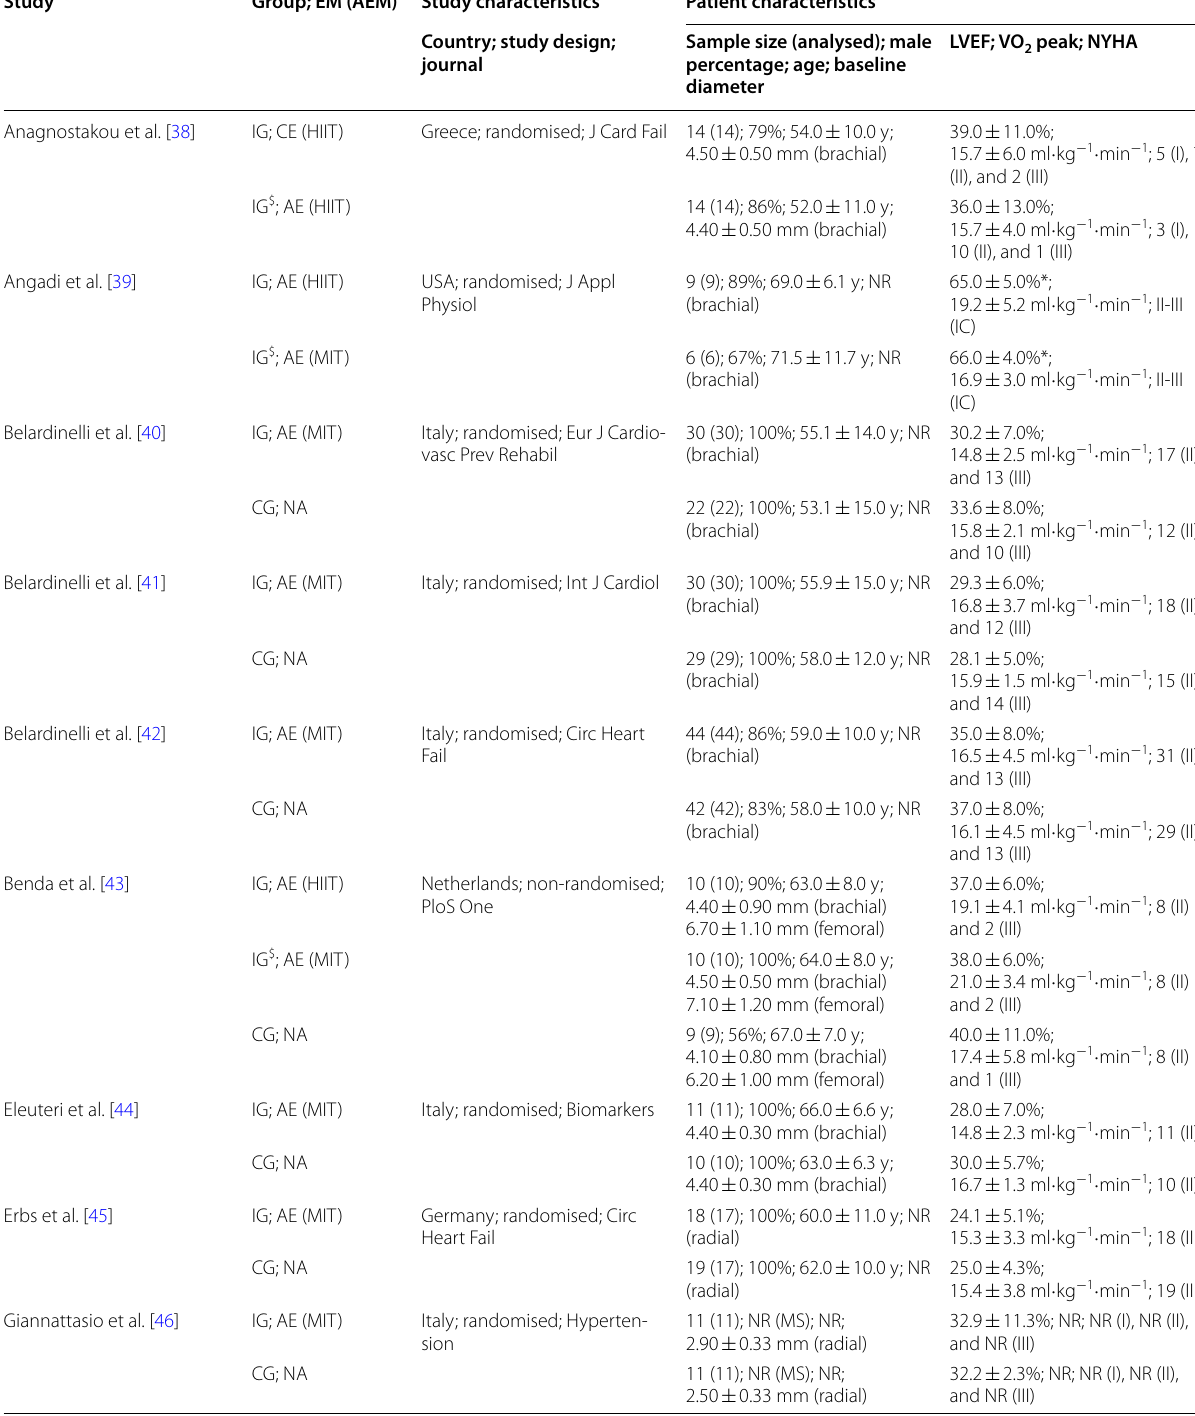
Table 1 Study and patient